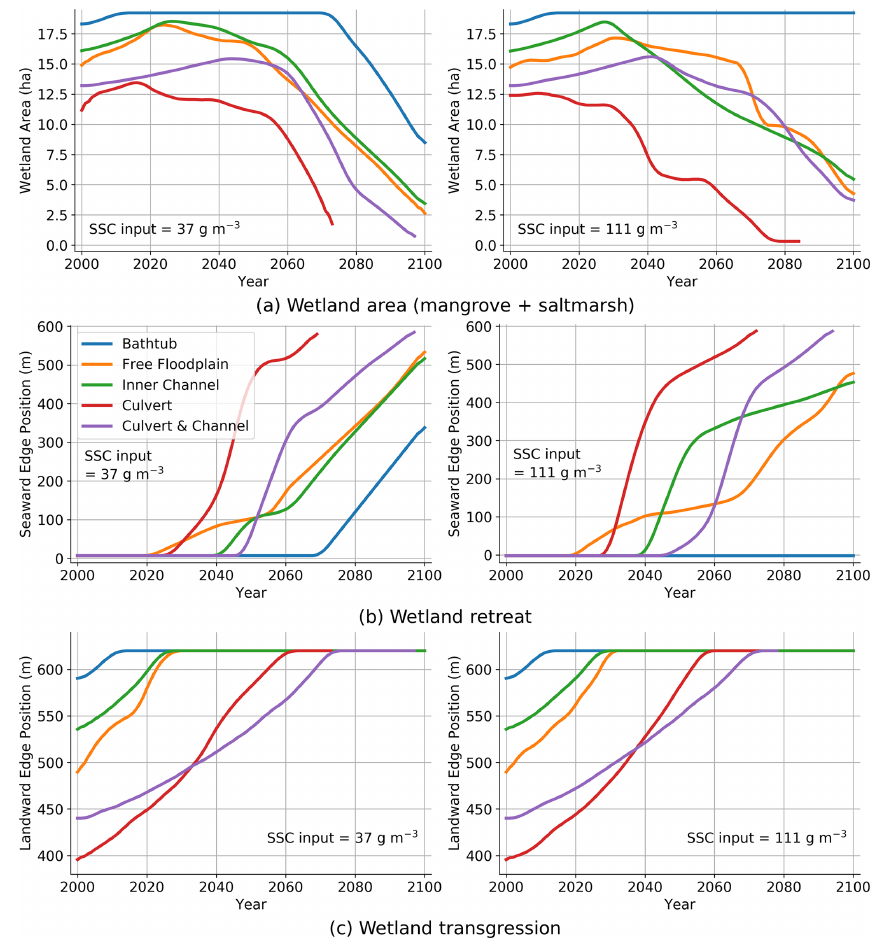
Figure 7. Time evolution of wetland in low (SSC = 37gm − 3 ) and high (SSC = 111gm − 3 ) sediment environments under SLR. (a) Wetland area; (b) ; wetland retreat; and (c) wetland